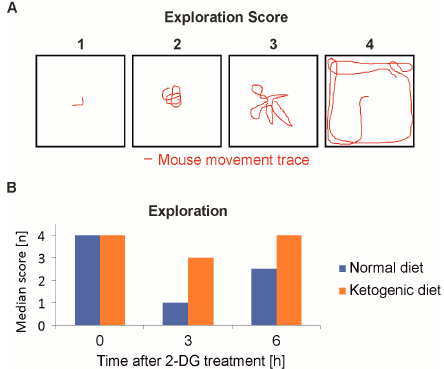
Figure 5. Mouse behavioral assessment after 2-deoxyglucoe treatment. ( A ) The behavior was assessed semi-quantitatively. Mice were placed in the middle of a transparent cube of 30 cm side length for one minute and the movement was recorded for later analysis. ( B ) Mice were fed either normal diet or ketogenic diet. Following intraperitoneal injection of 4 g/kg 2-DG, the level of sedation as the main side effect of 2-DG was examined by the standardized evaluation of the exploration behavior. The mice fed the ketogenic diet were less sedated and recovered